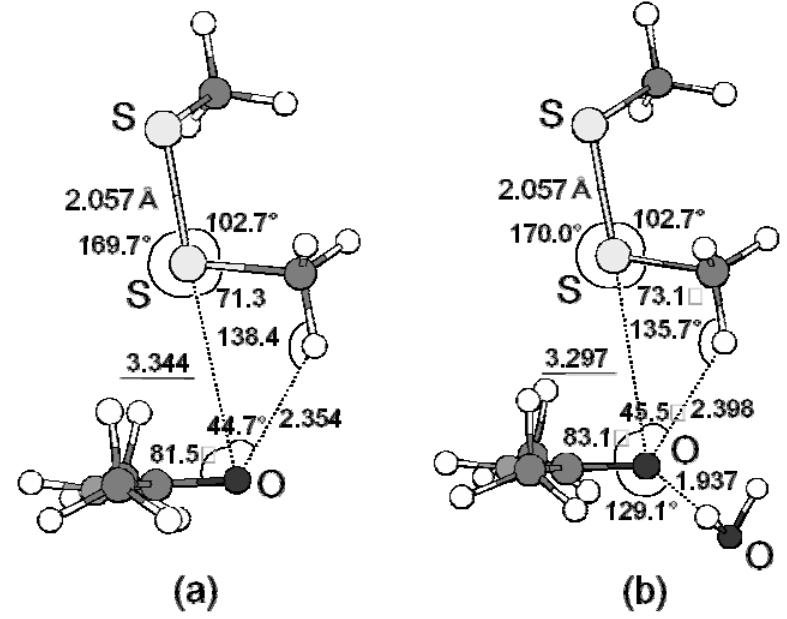
Figure 4. Optimized structures of the complexes between CH without H O ( a ) or with H 2